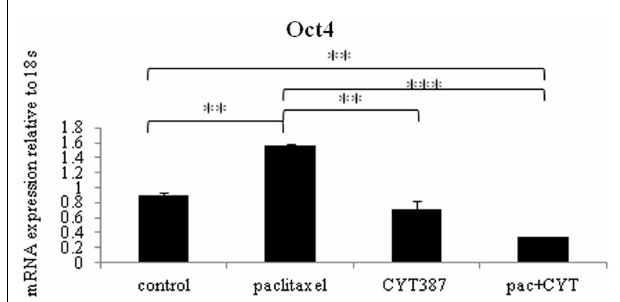
FIGURE 7 |The mRNA expression of embryonic stem cell marker Oct4 in xenografts generated from subcutaneous transplantation of HEY cells into mice administered with or without paclitaxel, CYT387, or a combination of paclitaxel and CYT387 (pac + CYT) . mRNA from xenografts generated from the control group and treatment groups was extracted, cDNA was prepared, and q-PCR for Oct4 was performed as described in the Section “Material and Methods.”The resultant mRNA levels were normalized to 18S mRNA.The experiments were performed using five independent samples in triplicate. Significant intergroup variations are indicated by ** p < 0.01 and *** p < 0.001.